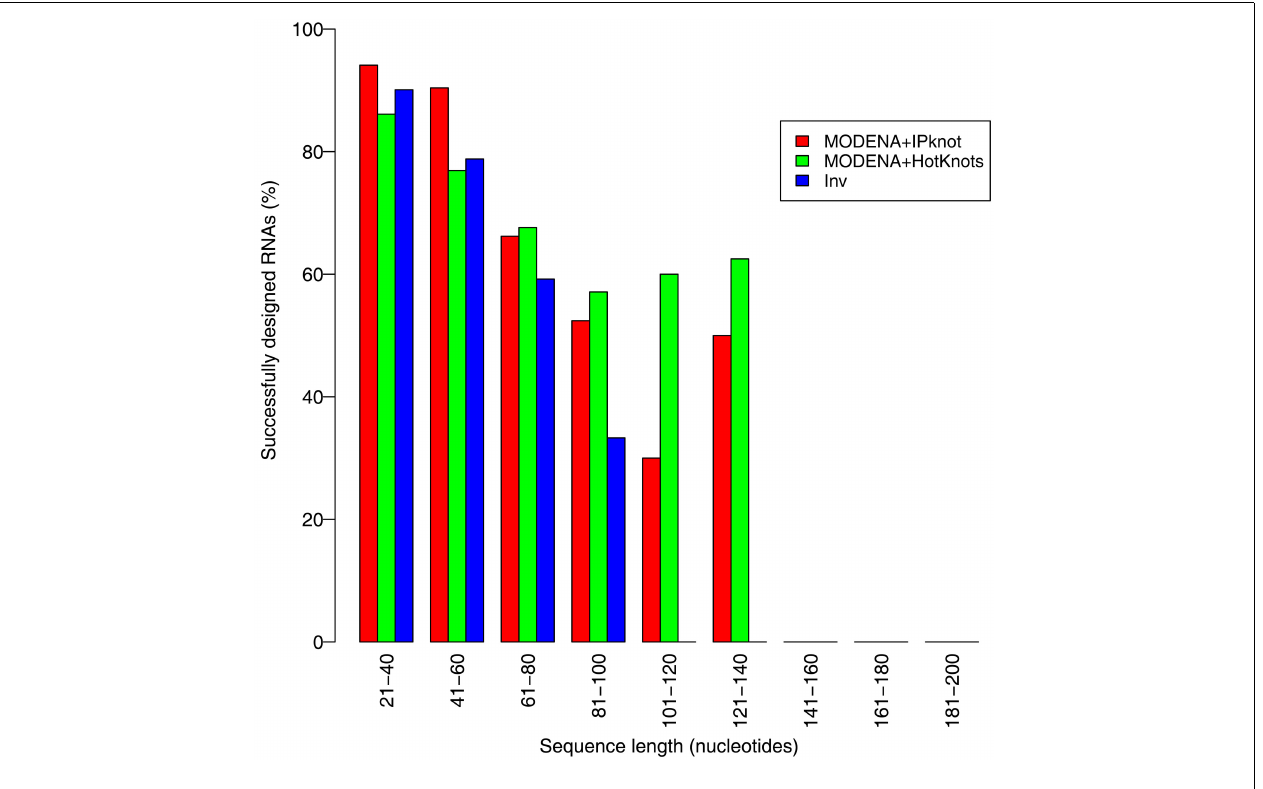
HotKnots as a direct problem solver, respectively. In each bin, results for MODENA + IPknot, MODENA + HotKnots and Inv are shown from left to